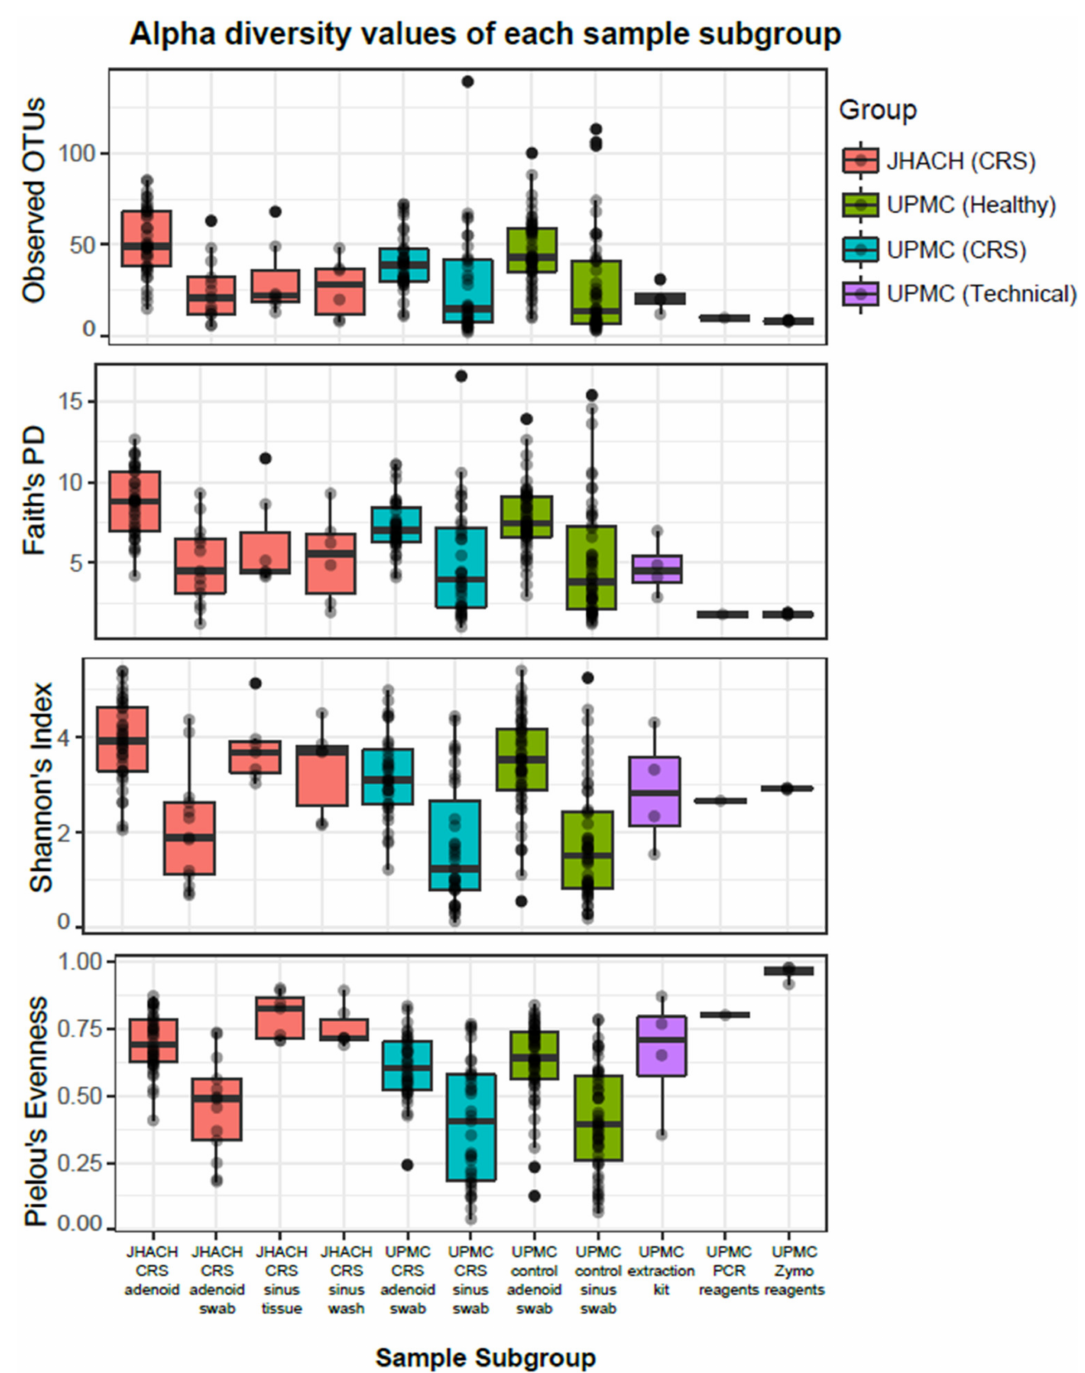
Figure 1. Alpha diversity values of each sample subgroup comprising samples from chronic rhinosi- nusitis (CRS) patients, healthy controls, or technical controls collected from the Johns Hopkins All Children’s Hospital (JHACH) or University of Pittsburgh Medical Center (UPMC) cohorts. Each point represents a sample and its corresponding alpha diversity value is represented on the y -axis. A high alpha diversity value indicates high bacterial richness and/or evenness within the sample. Samples were aggregated into subgroups corresponding to the cohort, disease status, and sample type, as indicated in the x